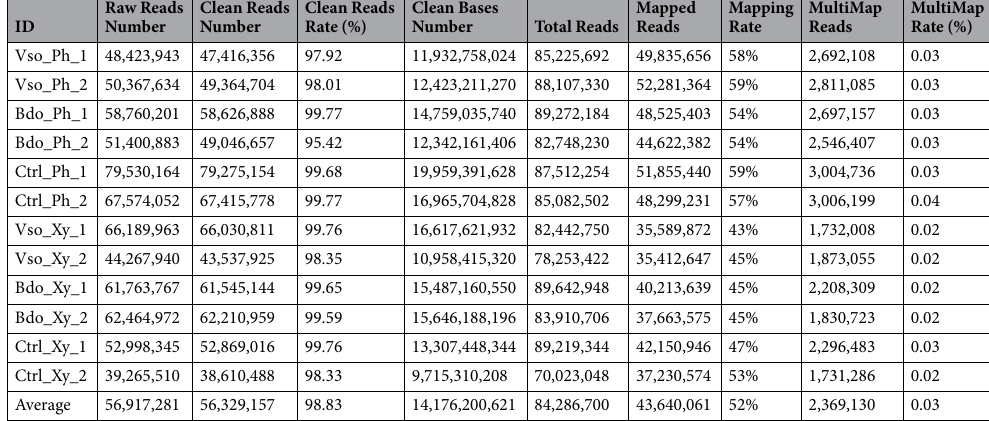
Table 1. Illumina RNA-Seq output statistics of poplar stems infected with canker